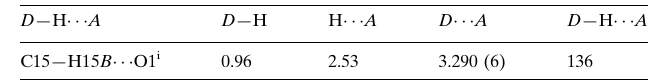
Hydrogen-bond geometry (A˚ , (cid:1)